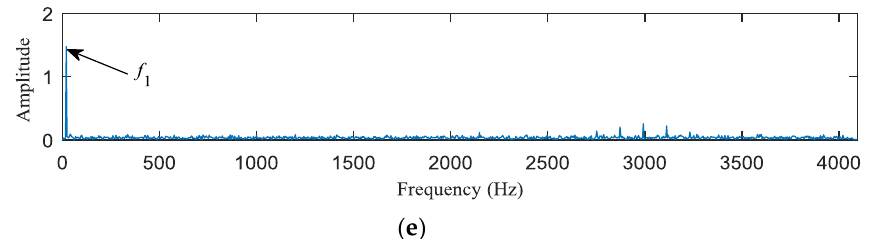
Figure 1. The simulated signal: ( a ) time waveform of x 1 ( t ); ( b ) time waveform of x 2 ( t ); ( c ) time waveform of x 3 ( t ); ( d ) time waveform of x ( t ); ( e ) envelope spectrum of x ( t ).